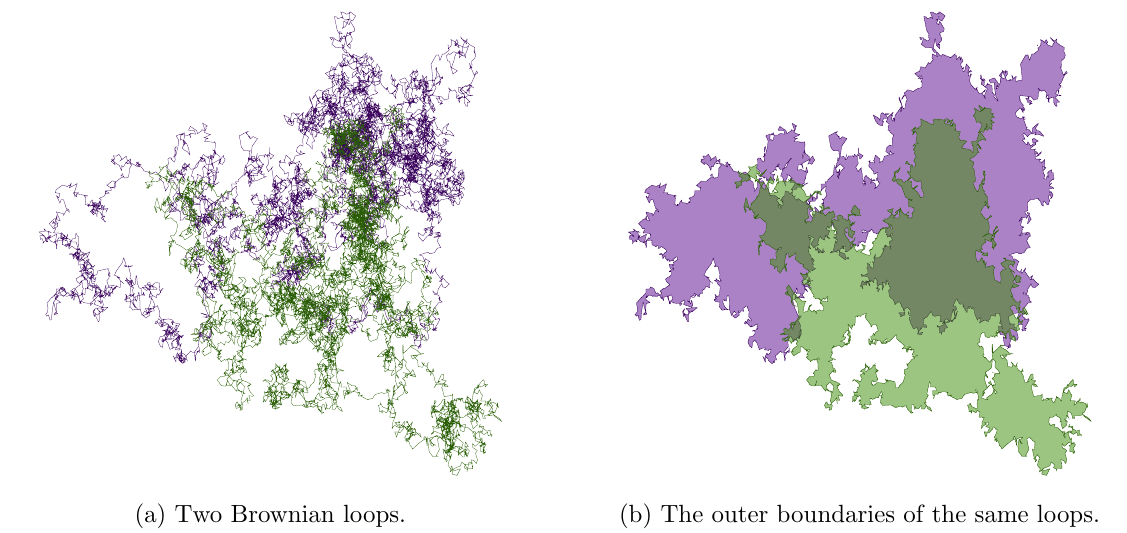
Figure 1. Two random Brownian loops with identical parameters. For z within its outer boundary, each loop contributes (cid:6) 1 to the layering number N ( z ), where the sign is chosen randomly and uniformly. If the purple loop is assigned +1 and the green loop (cid:0) 1, N ( z ) = 0 for z in the white or dark green areas, +1 in the purple, and (cid:0) 1 in the light